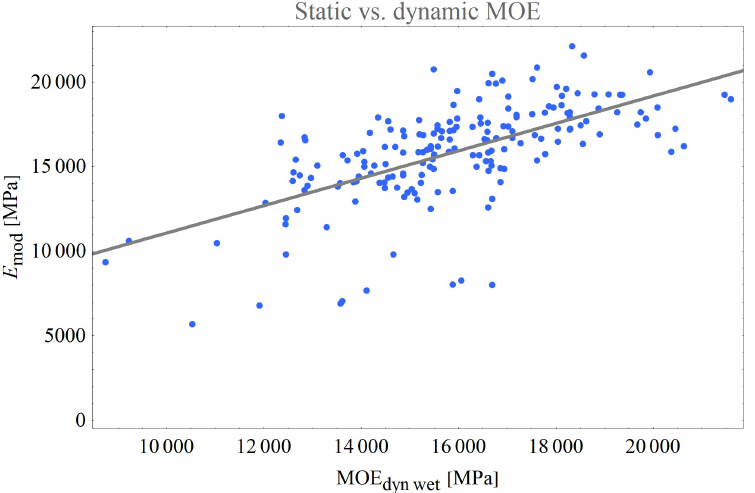
Figure 17. Comparison of static MOE from tension tests and dynamic MOE from boards at wet moisture